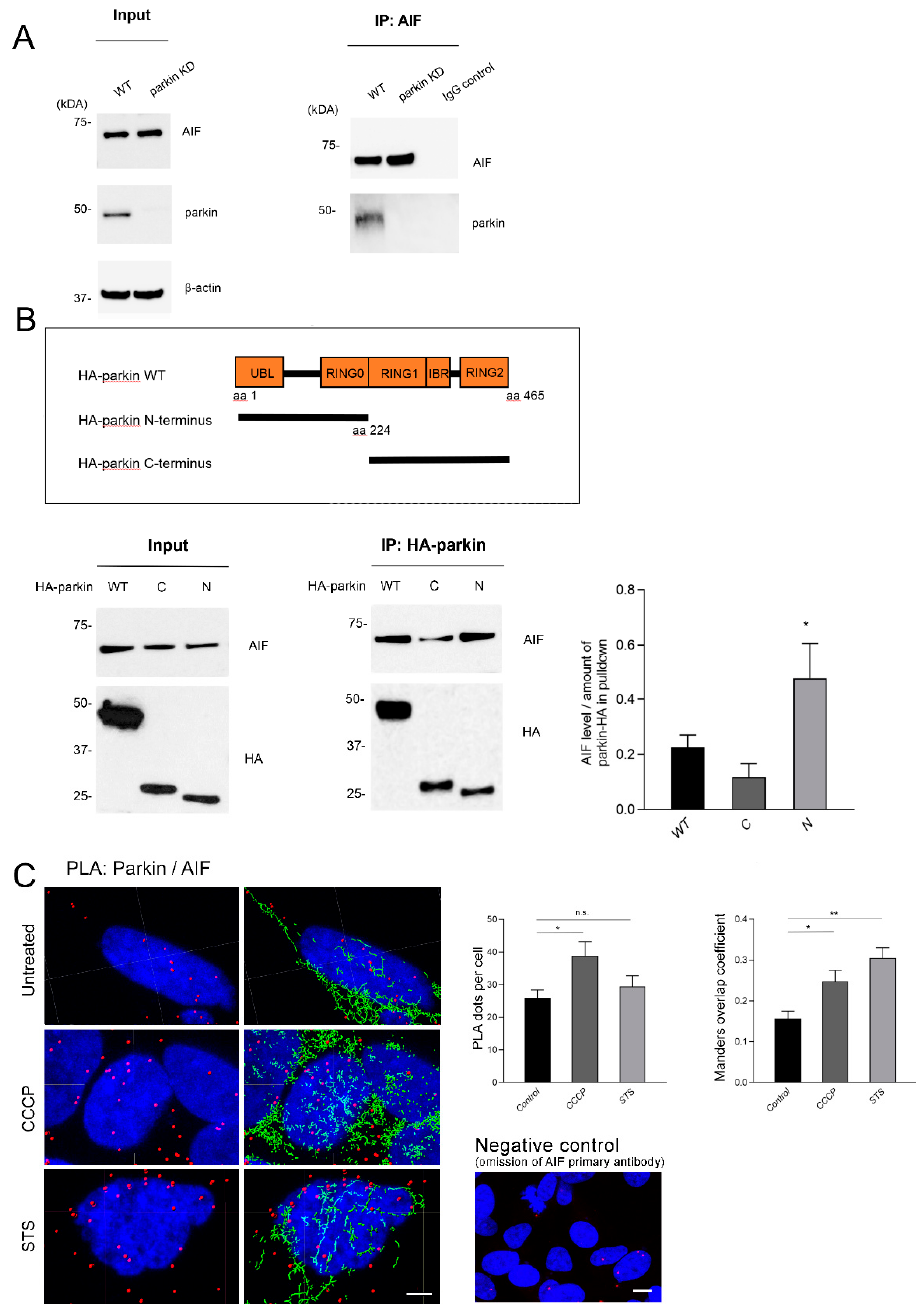
Figure 1. Parkin physically interacts with the apoptosis-inducing factor (AIF). ( A ) Whole-cell lysates of untreated SH-SY5Y cells with endogenous parkin levels (WT) and parkin knockdown (KD) were subjected to co-IP with an anti-AIF antibody, followed by Western blot (WB) of input and IP fractions with the indicated antibodies (the blots were probed consecutively with the antibodies). Rabbit IgG was used as negative control for the IP. Molecular mass markers are in kilodaltons (kDa). ( B ) Whole-cell lysates of HeLa cells transfected with HA-parkin (wild type, WT, C-terminal domain, C, N-terminal domain, N) were immunoprecipitated with an anti-HA antibody. WB analysis was performed with the indicated antibodies. Given the difference in expression levels of full-length HA-parkin and deletion mutants, a densitometric analysis of AIF relative to immunoprecipitated parkin is provided (mean ± SEM, n = 4). Two-tailed Student’s t -test for C- and N-terminal domains * p < 0.05. ( C ) SH-SY5Y cells were processed using the PLA to visualize and quantitatively assess the parkin-AIF interaction under normal culture conditions and after CCCP (10 µ M, 3 h) or STS (2 µ M, 3 h) treatment. The PLA signal